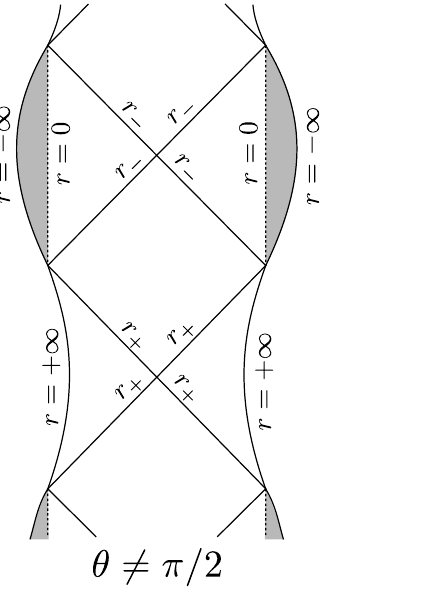
Figure 12 . Fixed θ projection diagrams of Kerr-AdS 4